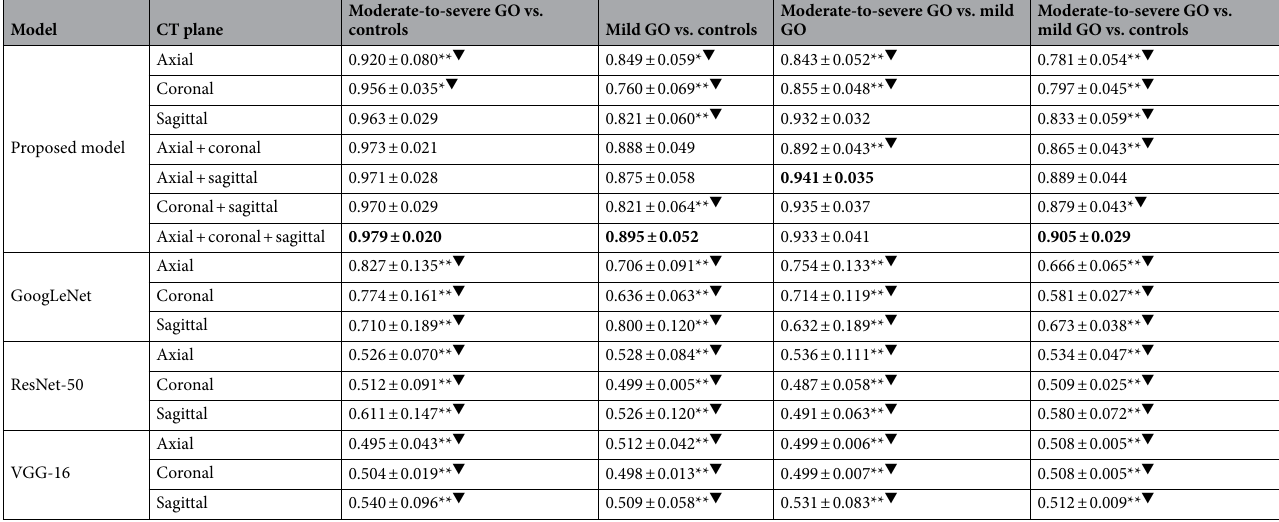
Table 2. AUCs of diagnostic ability for Graves’ orbitopathy using NNs. AUC area under the curve, CT computed tomography, GO Graves’ orbitopathy, NN neural network. ▼ indicates that the